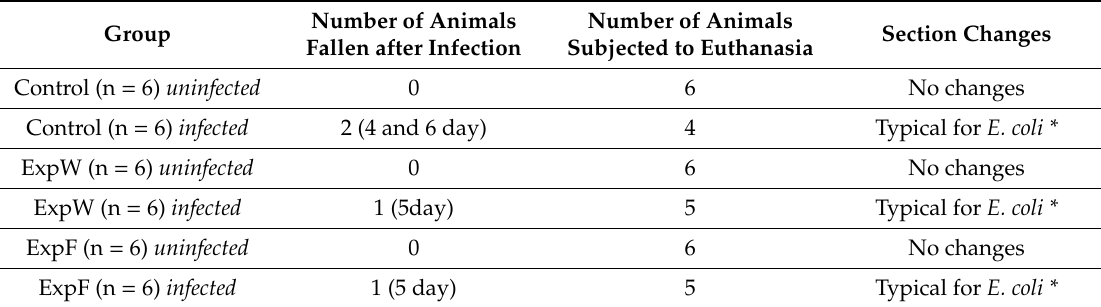
Table 6. Mortality of rabbits after experimental E. coli infection (strain O103 eae +